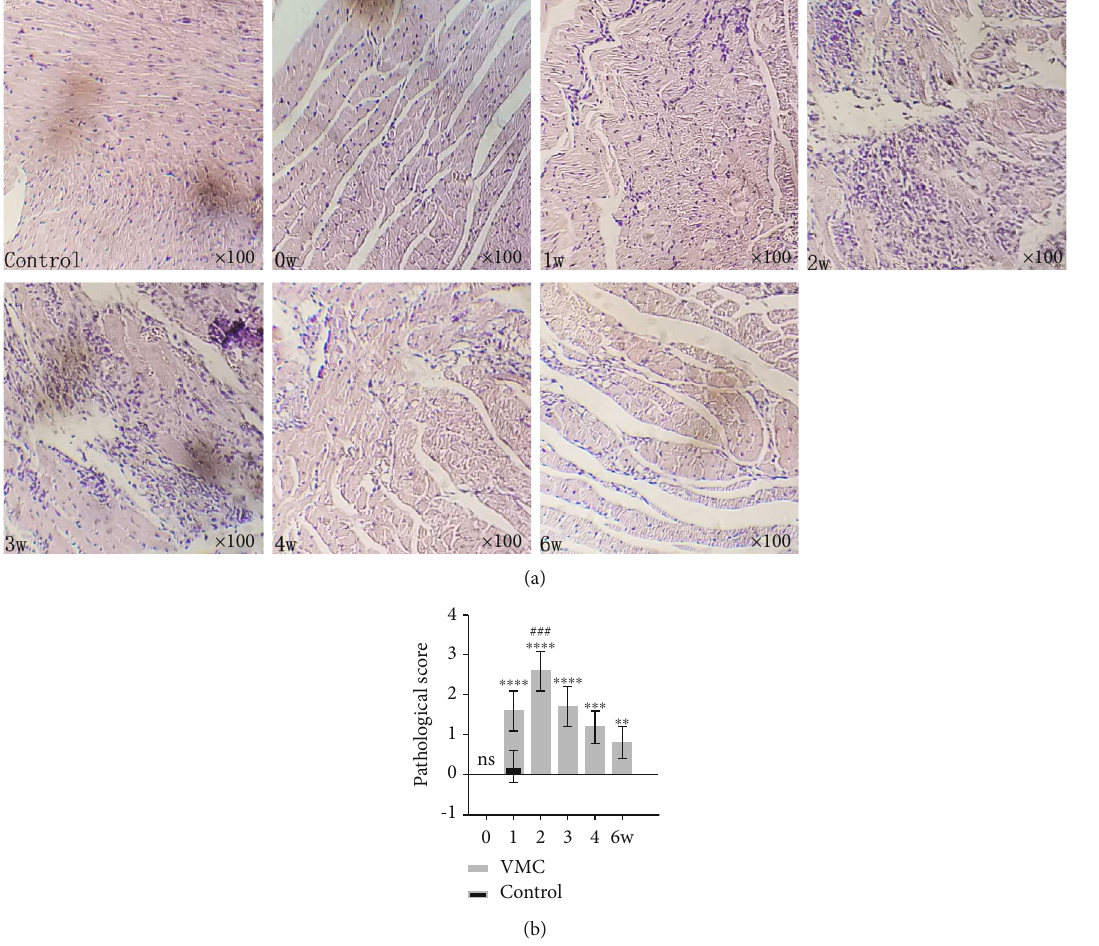
Figure 1: Myocardial pathological changes in VMC process. (a) HE images of in fl ammation during the six-week VMC modeling process (original magni fi cation × 100). (b) Pathological score at di ff erent time points. Statistical description: ns, ∗∗ , ∗∗∗ , and ∗∗∗∗ stand for no statistically signi fi cant di ff erence, P < 0 : 01 , P < 0 : 001 , and P < 0 : 0001 , respectively, for the VMC group versus the control group at di ff erent time points. ### means P < 0 : 001 for the week 2 VMC group versus week 0, 1, 3, 4, and 6 VMC